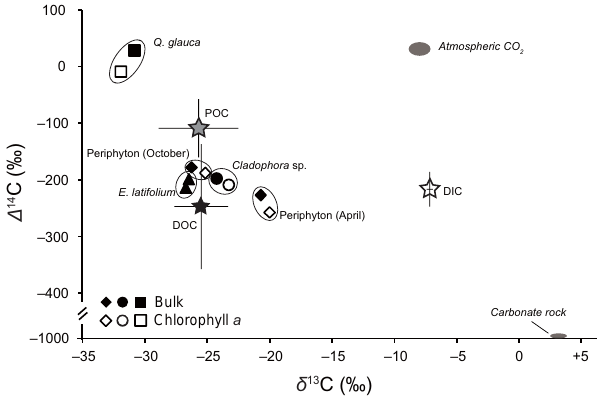
Figure 2. Biplot of δ 13 C and (cid:49) 14 C data. Carbonate rocks in the Seri River ( δ 13 C = + 3.9 ± 0.3‰ and (cid:49) 14 C =− 1000‰; Ishikawa et al., 2015) and atmospheric CO 2 ( δ 13 C and (cid:49) 14 C are approx- imately − 8 and + 30‰, respectively, in 2013) are also shown as